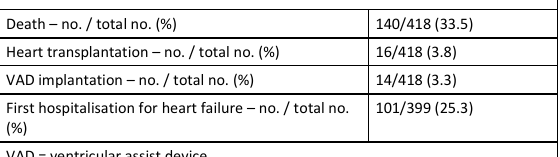
Table 2: Endpoints during long-term